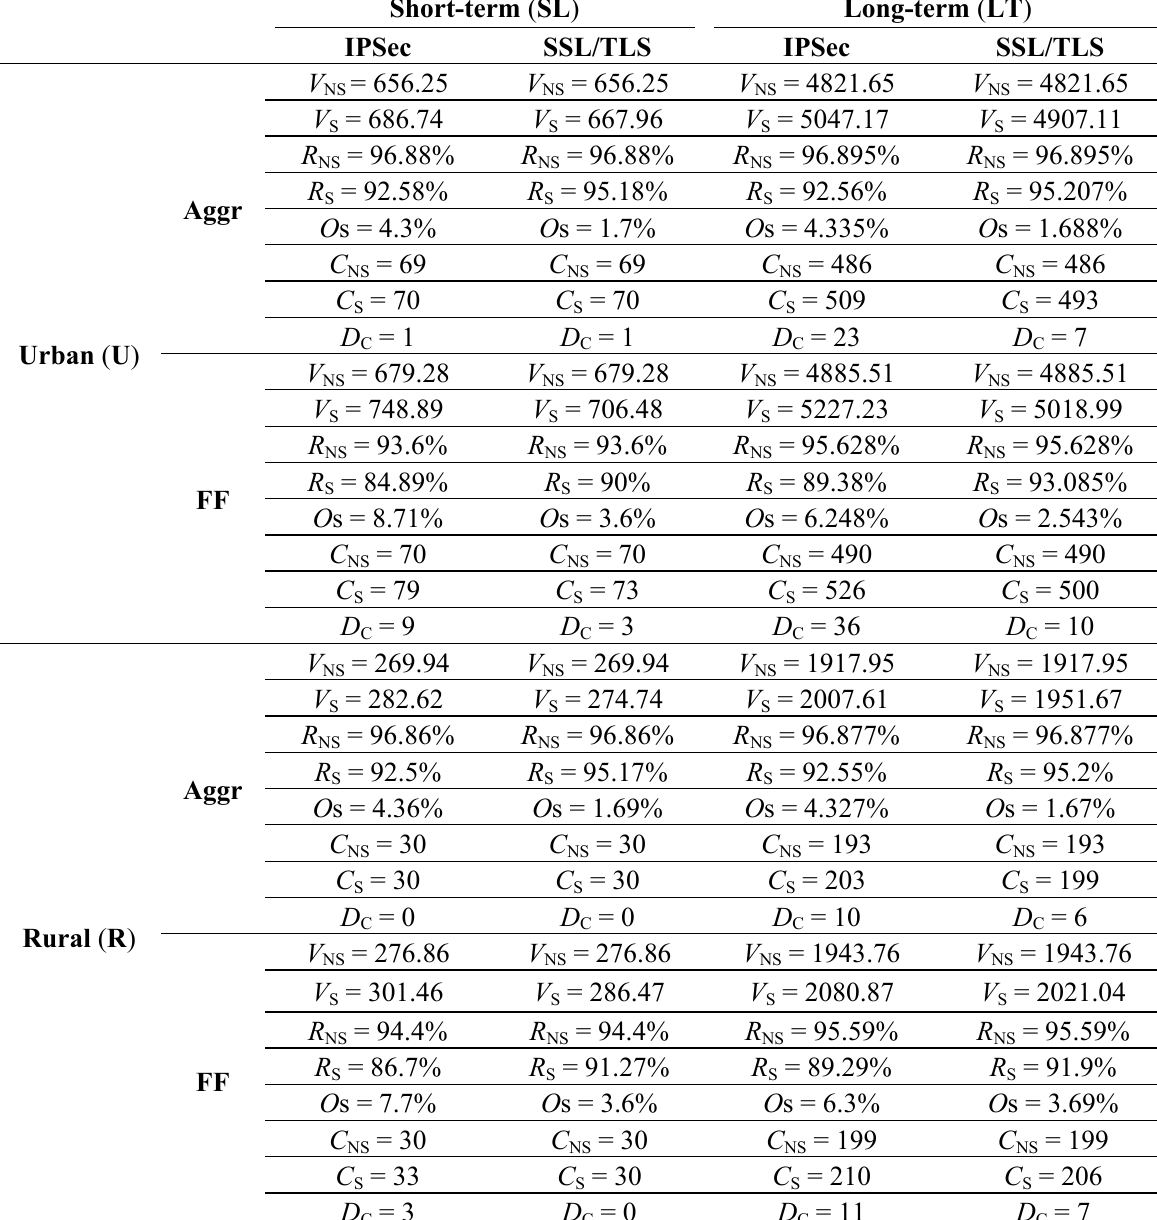
Table 6. Summary of the results of the analysis of the impact on the operational costs of using IPSec or